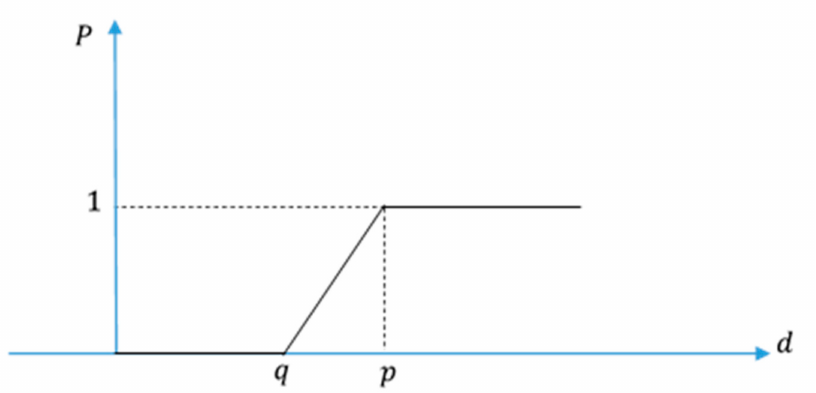
Figure A2. Preference function in PROMETHEE